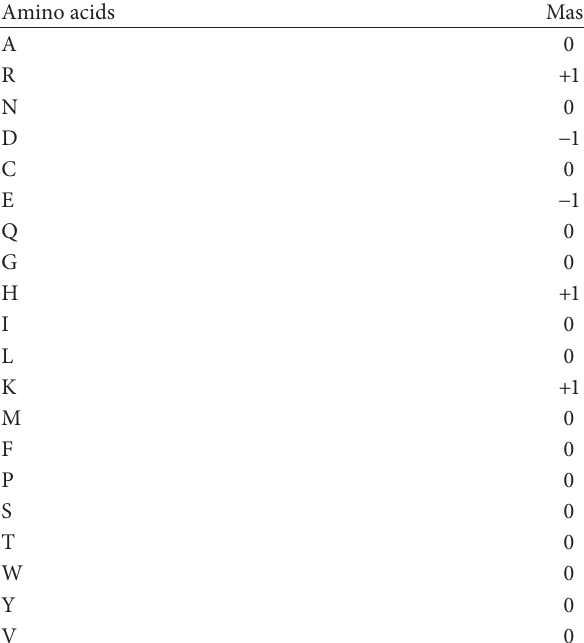
Table 2: Net charge of amino acids. Amino acids